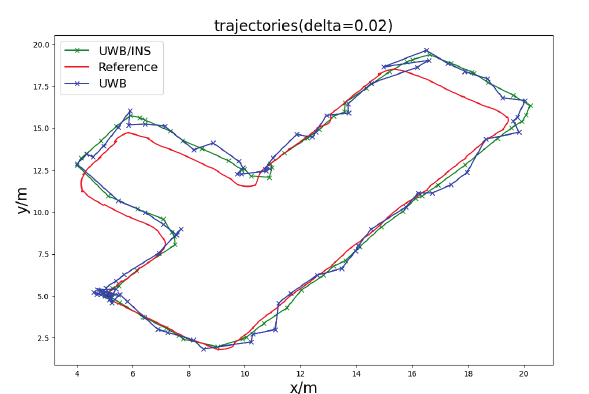
Figure 8 . Comparison of reference trajectory, UWB trajectory, and UWB/INS integration trajectory when ( are the diagonal elements of the observation noise covariance